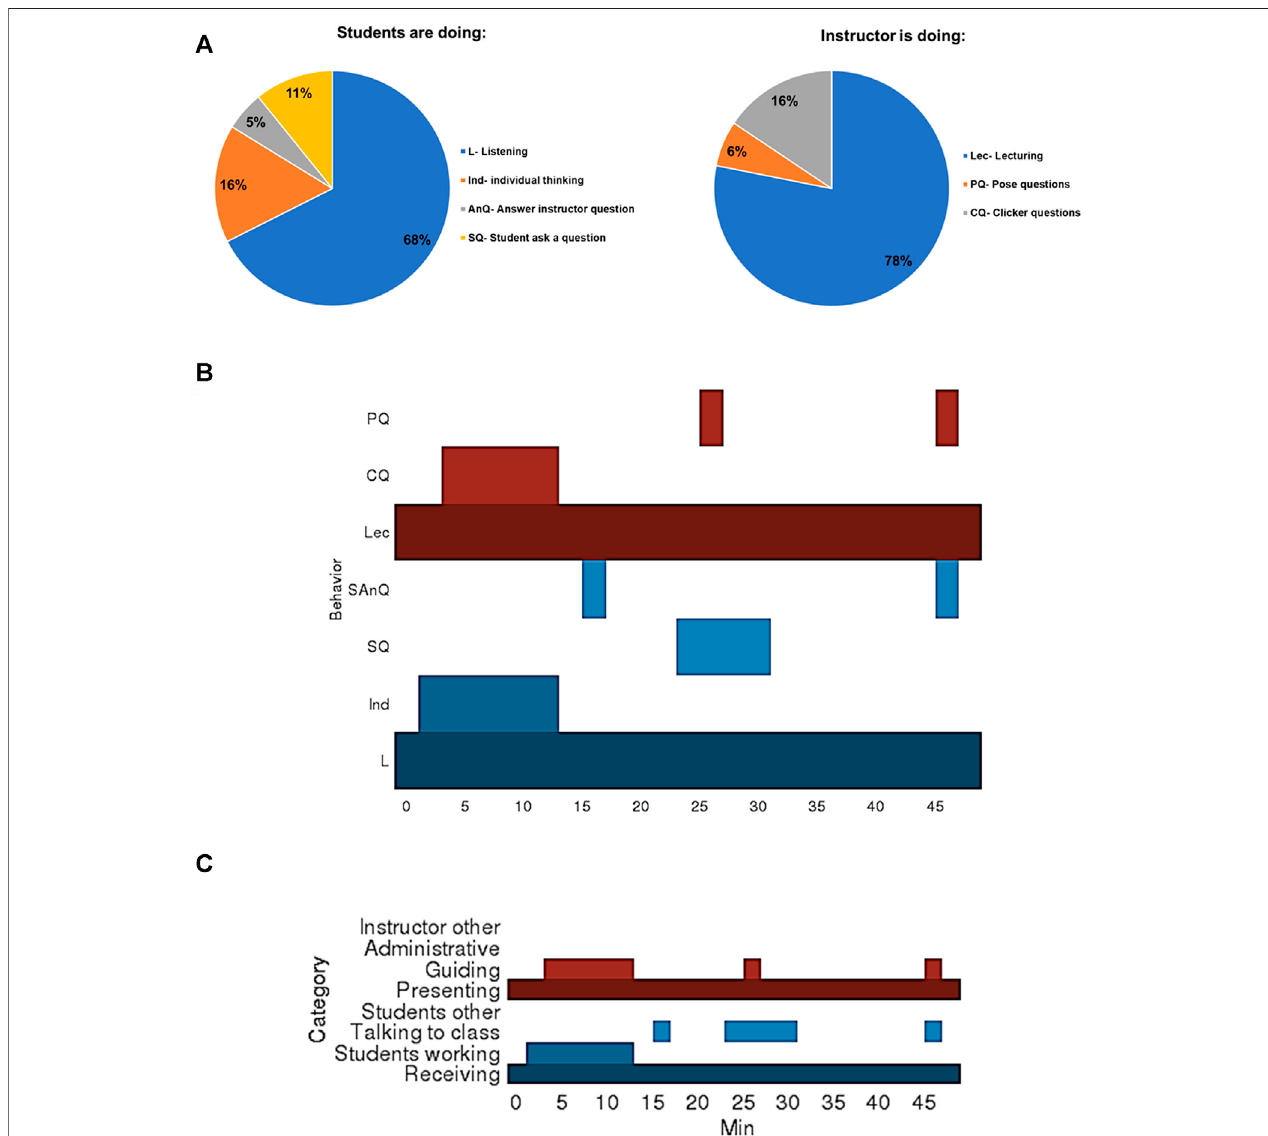
FIGURE 1 | COPUS assessment outcome for a single Course lecture evaluated. The two pie charts (A) show the type and frequency (percentage) of the activities done by students and instructors in the classroom. The heatmap (B) produced by the COPUS Analyzer (unmodi fi ed outputproduced bythe website) demonstrates the type and timing of the activities done by students (blue) and instructor (red) in the classroom during the same lecture. Out of the 25 existing codes, only a few of the COPUS codes were identi fi ed during this lecture that is shown in this fi gure. L, Listening; Ind, individual thinking; AnQ, Answering instructor question; SQ,